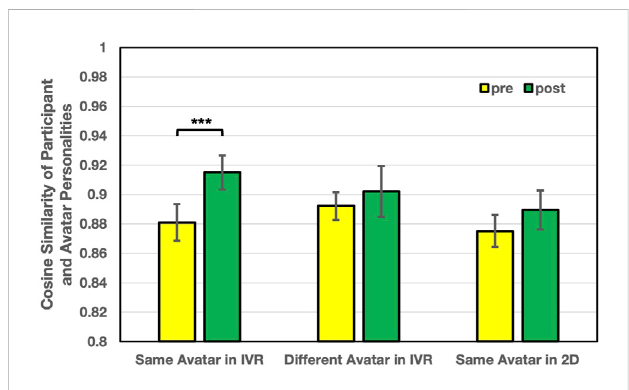
FIGURE 4 Cosine similarity of participant and avatar personalities (G1: Same Avatar in IVR, G2: Different Avatar in IVR, G3: Same Avatar in 2D). The error bars denote standard error, *** p < .001.